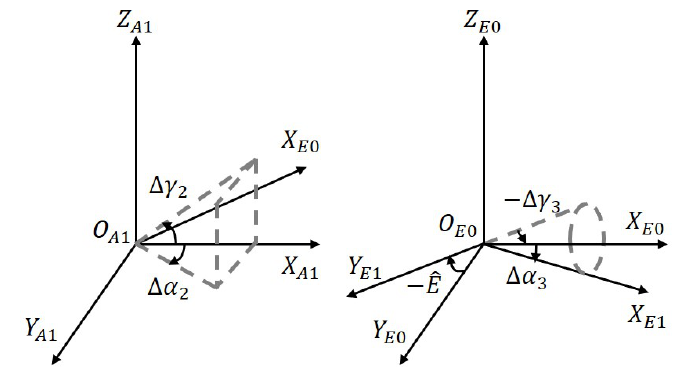
Figure 6. Shafting errors of the elevation axis.